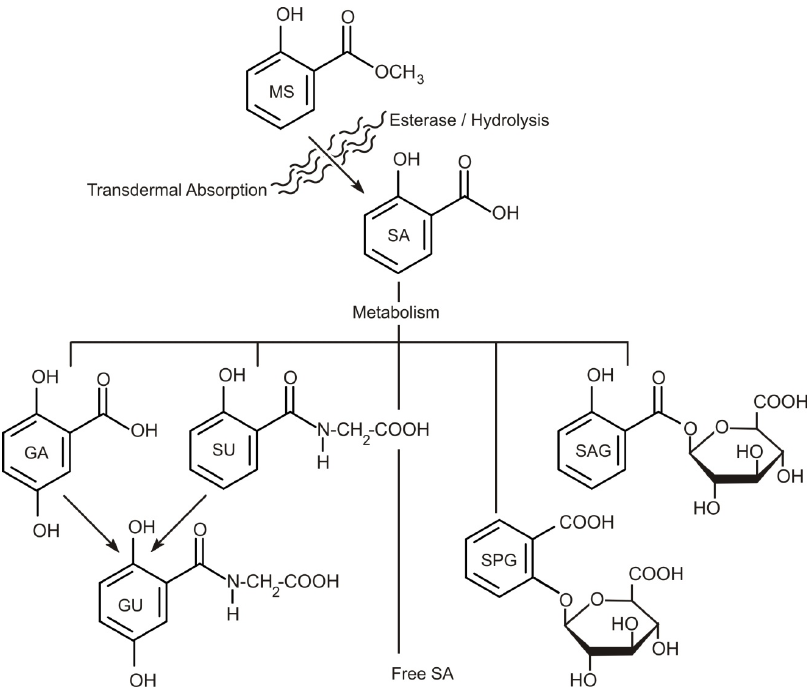
Figure 2. Metabolites of salicylic acid (SA); SPG: salicylic acid phenolic glucuronide; SAG: salicylic acid acyl glucuronide; SU: salicyluric acid; GA: gentisic acid; GU: Gentisuric acid [49,50].